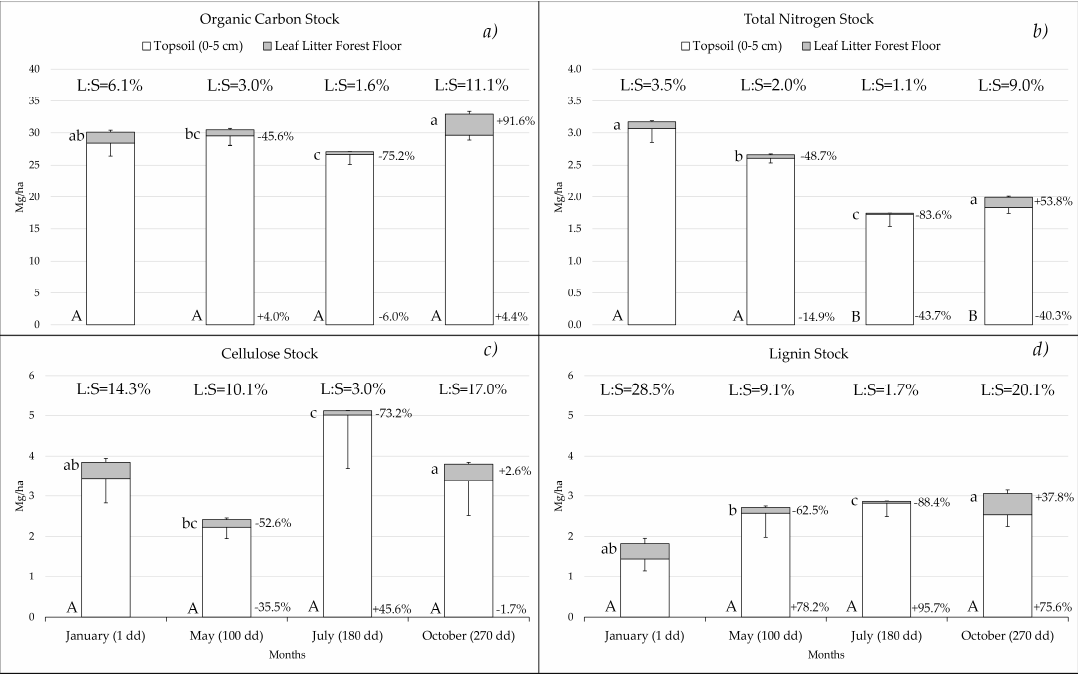
Figure 2. Dynamics of organic carbon ( a ), total nitrogen ( b ), cellulose ( c ) and lignin ( d ) stocks in the forest floor leaf litter (upper grey bars) and topsoil (lower white bars). Each bar is accompanied by the relative increase or decrease in the stock compared to January. The presence of significant differences between sampling per compartment was tested by the mean of a one-way ANOVA followed by a Tukey post-hoc test. Such differences are shown as lowercase letters for forest floor leaf litter and uppercase letters for topsoil. Bars which do not share a letter have significant differences ( p < 0.05). At the top of each graph, the ratio between the stocks in the forest floor leaf litter and topsoil is shown. Months and decomposition days in the litterbag experiment (dd) are reported. L:S indicates the ratio between the stock in leaf litter forest floor and the topsoil.